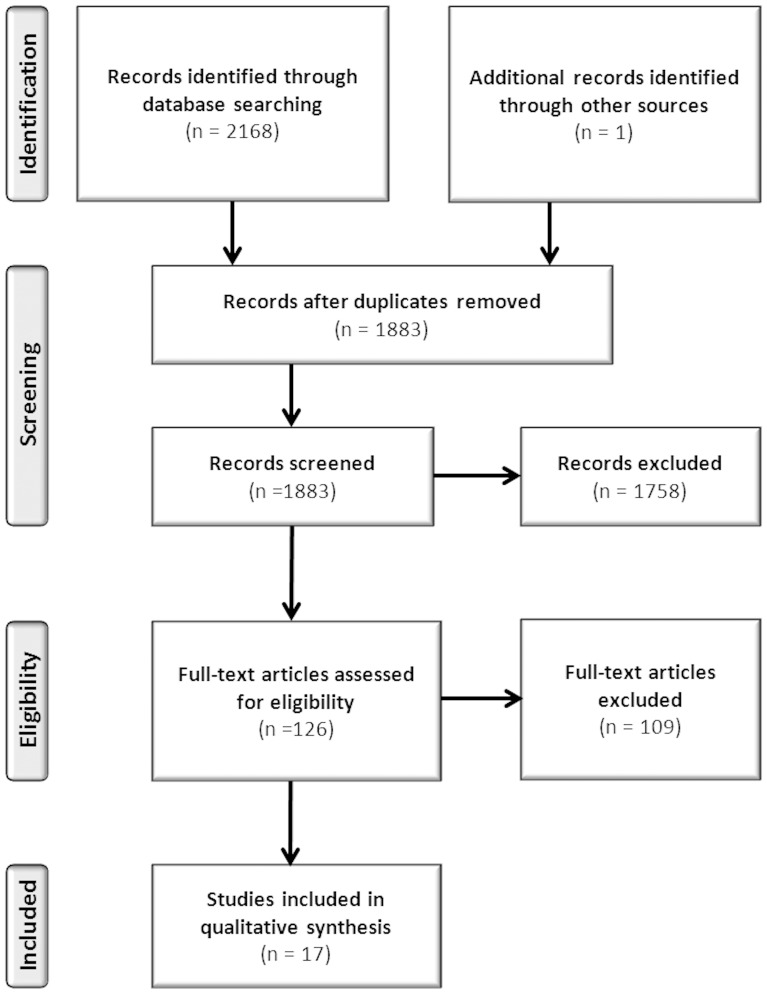
Summary of search strategy.